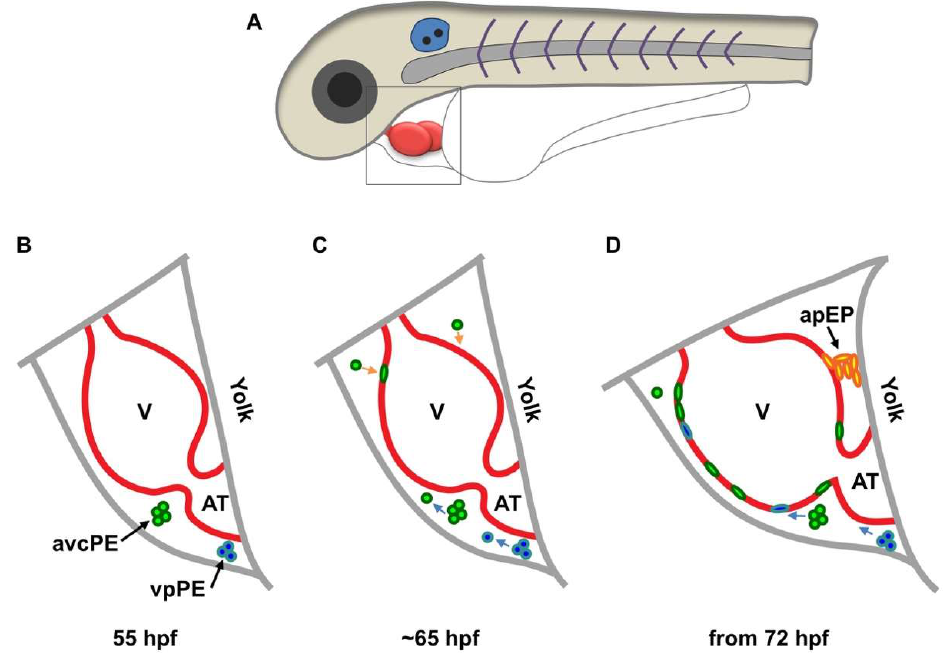
Figure 1. Schematic of epicardium formation in zebrafish. ( A ) Schematic of the anterior half of a zebrafish embryo. The framed region in (A) is enlarged to show details below ( B – D ); (B) at approximately 55 hpf, two PE clusters emerge from the mesothelial wall close to the atrioventricular canal (avcPE) and the venous pole PE (vpPE); (C) from approximately 65 hpf, cells are released (blue arrows) from the PE clusters and start to attach to the ventricular surface (orange arrows); (D) from 72 hpf, cells from the arterial pole epicardial precursor (apEP) pool (black arrow) are transferred to the ventricular surface through a cell bridge. V, ventricle; AT, atrium.